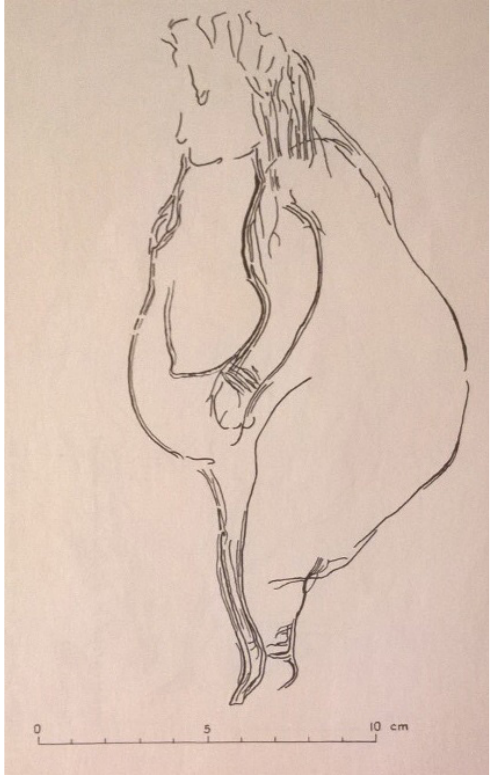
Figure 11. Group α, examples of Hand α3: Obs. 36(I) (from Pales,